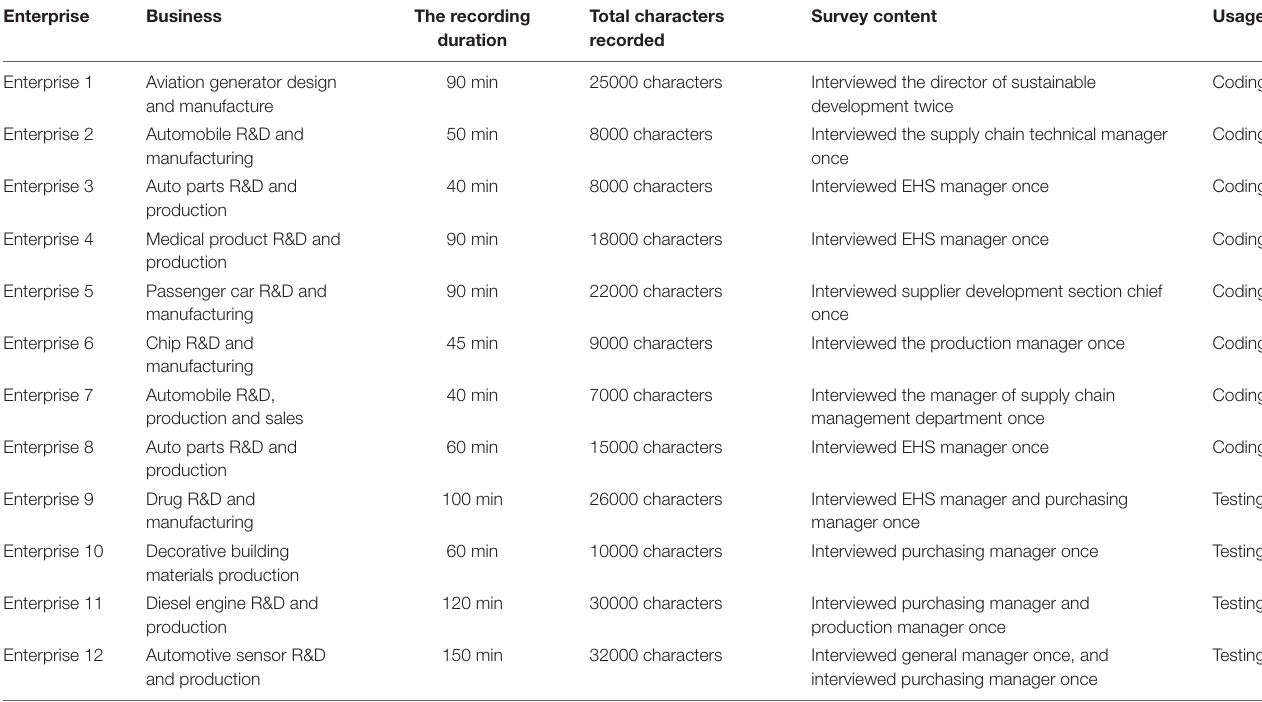
TABLE 1 | Basic information of in-depth